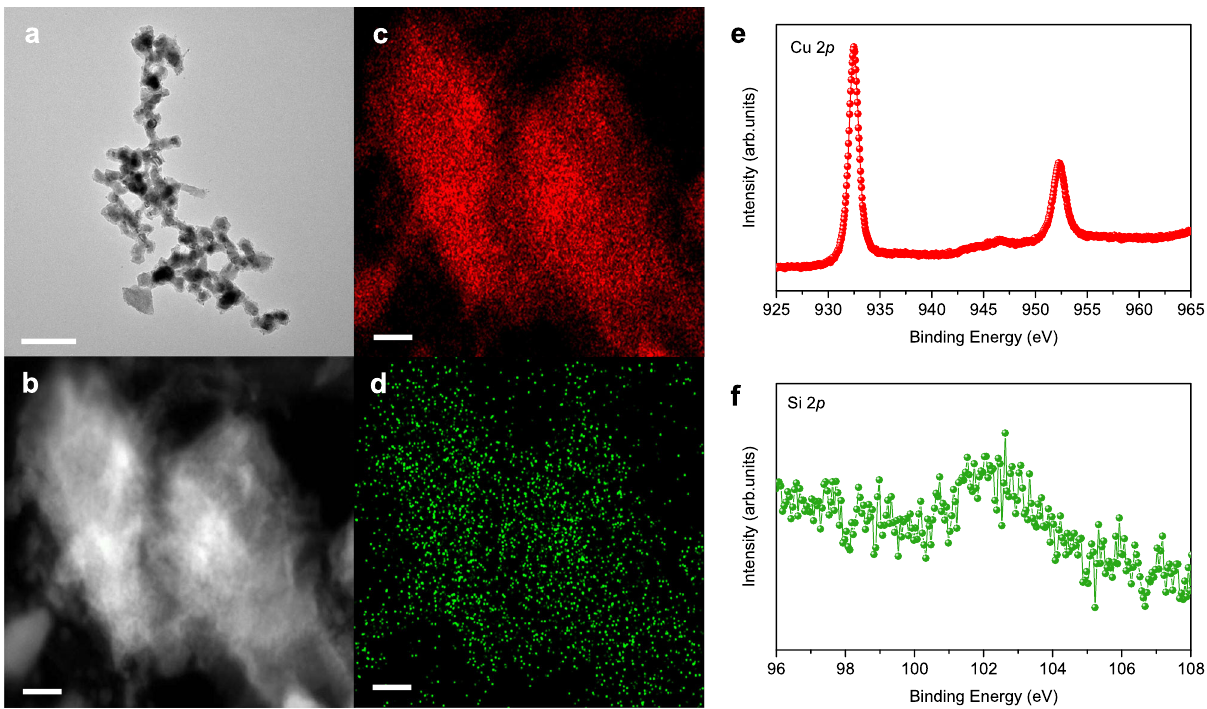
Fig. 2 Characterization of 2.5% silica-loaded Cu catalyst. a – d TEM image ( a ), HAADF-STEM image ( b ), and EDX elemental mapping of Cu ( c ) and Si ( d ). The scale bars are 200 nm in a and 20 nm in b – d . e , f XPS spectra of Cu 2 p ( e ) and Si 2 p ( f ). All measurements were performed upon completion of CO 2 RR at a full-cell potential of − 4.1 V in 0.1 M KHCO 3